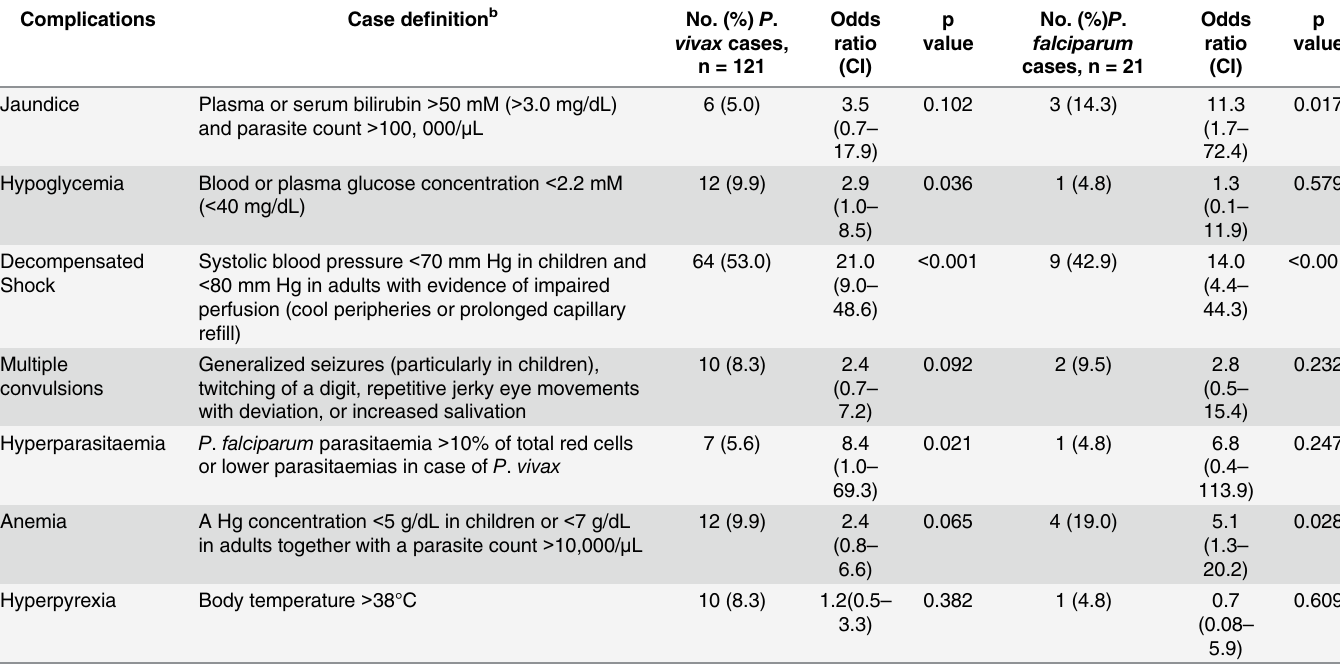
Table 2. Comparison of complication rates in P . vivax versus P . falciparum infections, Orakzai Agency, Pakistan, 2011 – 2013 a .